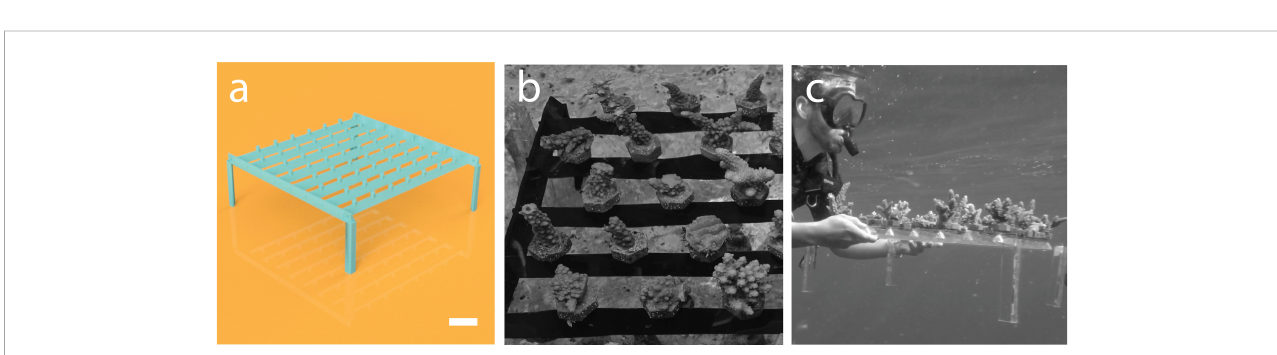
FIGURE 2 Maritechture ™ Coral crate (patent pending, 63/187,218 and 29/783,128, “ Coral farm crate and methods of use thereof ” May 11, 2021). (A) Stackable coral crate. White bar indicates 10 cm in width. (B) Coral tiles on coral frame. (C) Easy and safe transport of